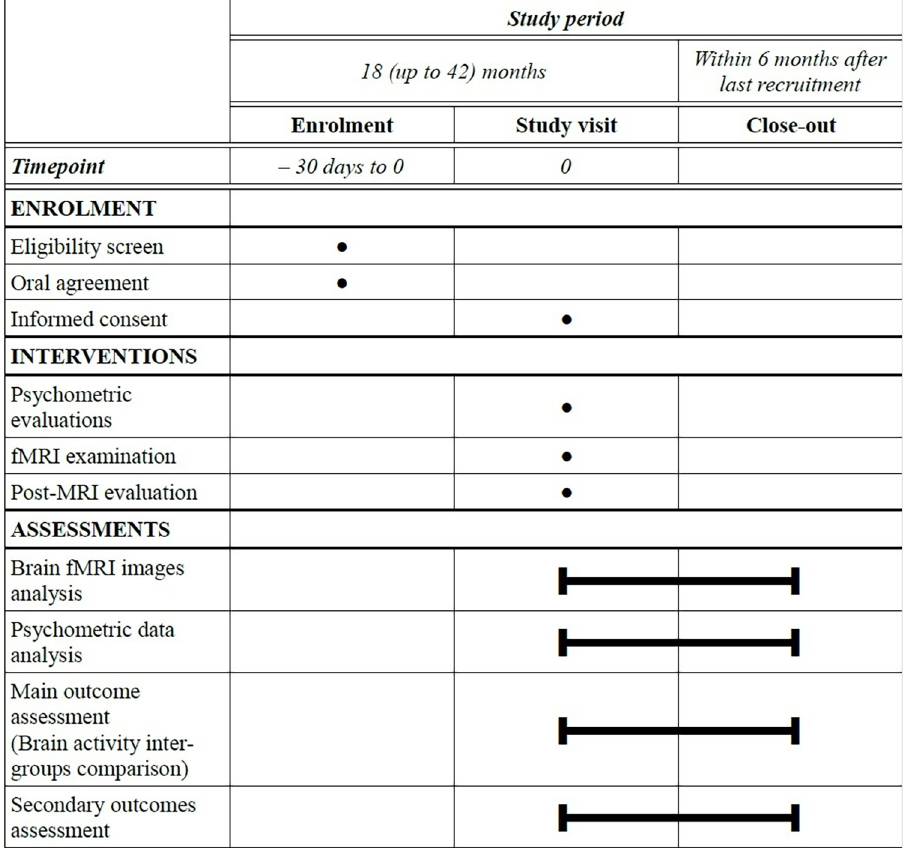
Fig 1. Study schedule